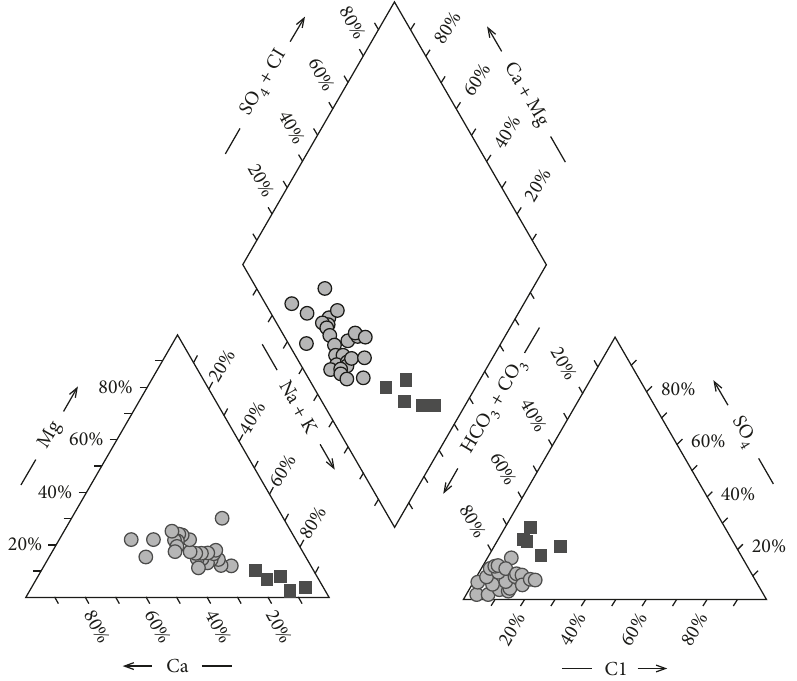
Figure 2: Piper diagram. Circles are for bicarbonate alkaline-earth and alkaline water (BAW) while squares represent the bicarbonate-sulphate-alkaline waters (high-salinity water, HSW). Data are from Parisi et al. [31,